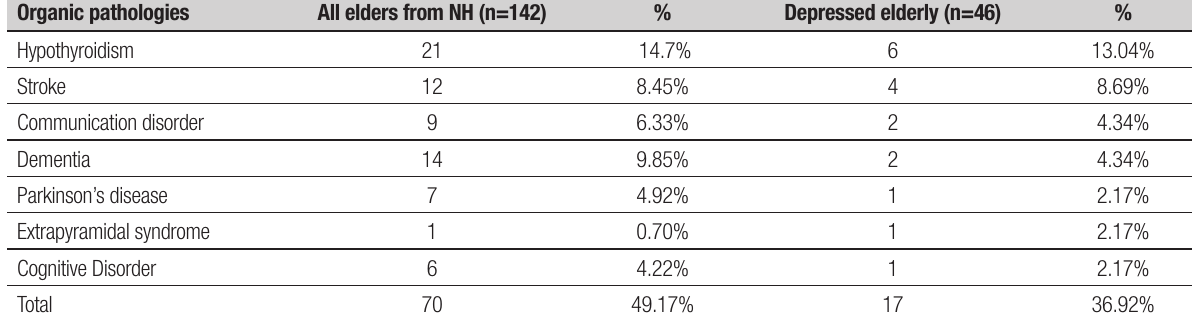
Table 2. Distribution of organic pathologies. Organic